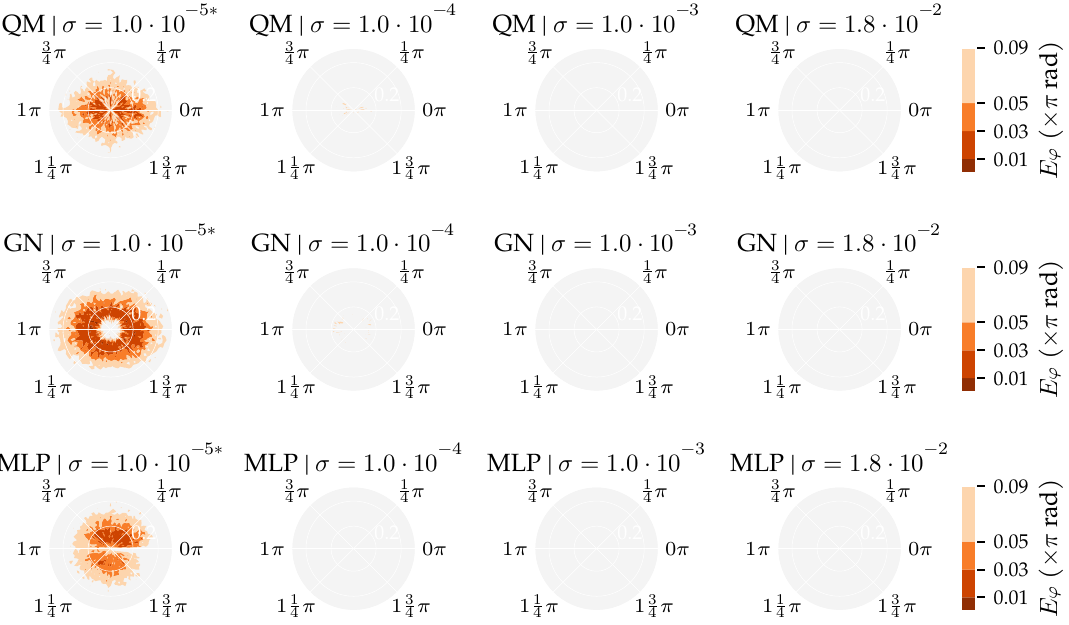
Figure A16. Polar contours of the median movement direction error (Equation (5)) for each localisation algorithm in all conditions of Analysis Method 2. These figures indicate how the movement direction ϕ and distance d of a source influence the error. The D s = 0.01 training and optimisation set and (x + y) sensor configuration were used. The values for σ = 1.0 × 10 − 5 ms − 1 are based on the D s = 0.01 condition in Analysis Method 1. The MLP was re-trained for each noise level. Both the MLP and GN used the optimal hyperparameter values from the D s = 0.01 condition of Analysis Method 1. The median movement direction error was computed in 2 × 2 cm 2 cells. The sensors were equidistantly placed between x = ± 0.2